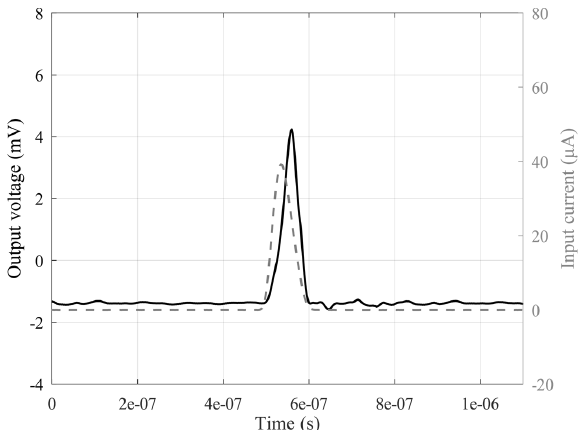
Figure 14. Input current pulse with a duration of 80 ns (grey trace, right axis) and output voltage signal of the defined SiPM interface (black trace, left axis). Sensors 2020 , 20 , x FOR PEER REVIEW